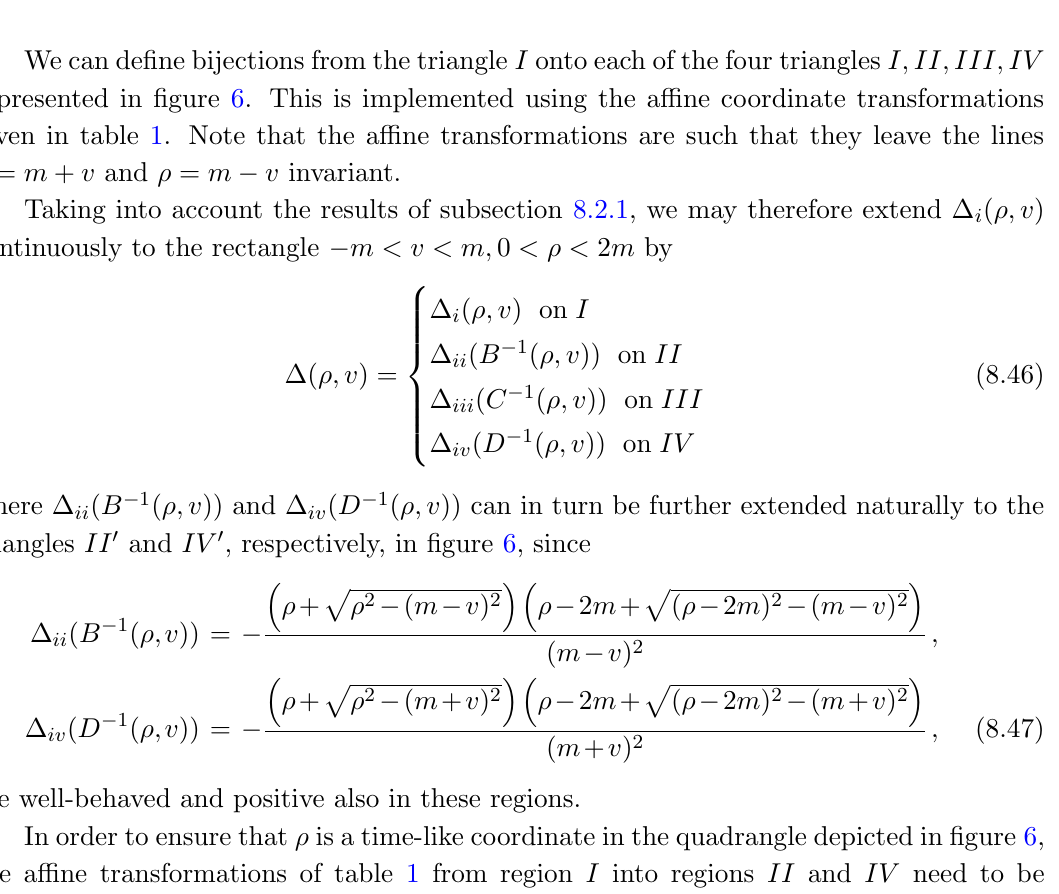
Table 1. Bijections between